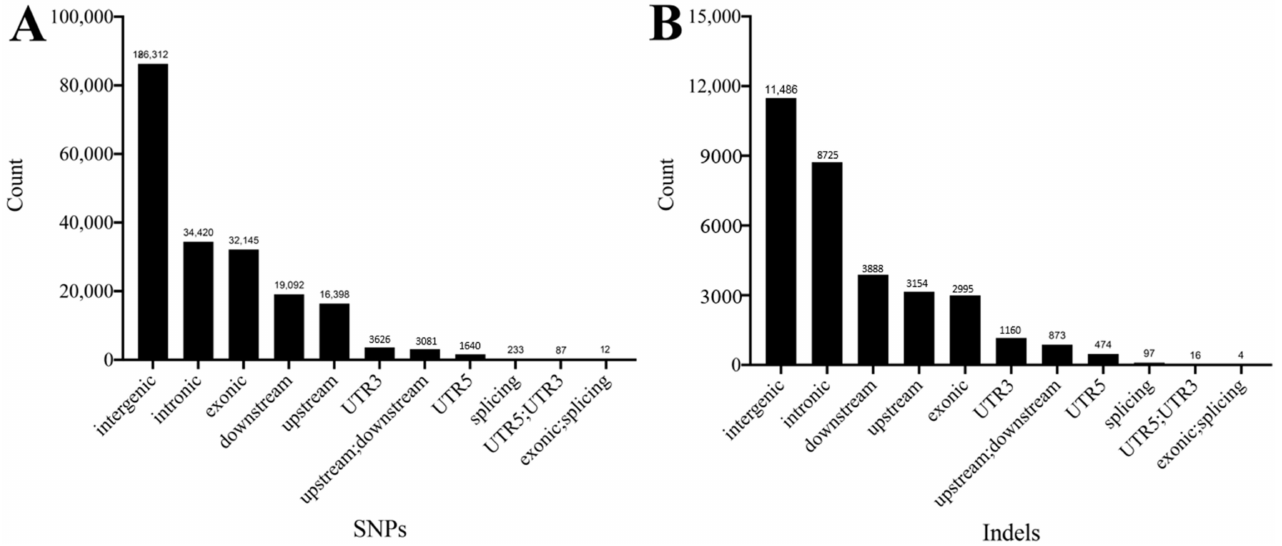
Figure 1. Statistics of SNPs ( A )/Indels ( B ) annotations. Abscissa: annotated region of SNPs/Indels; Vertical coordinate: number of SNPs/Indels in different